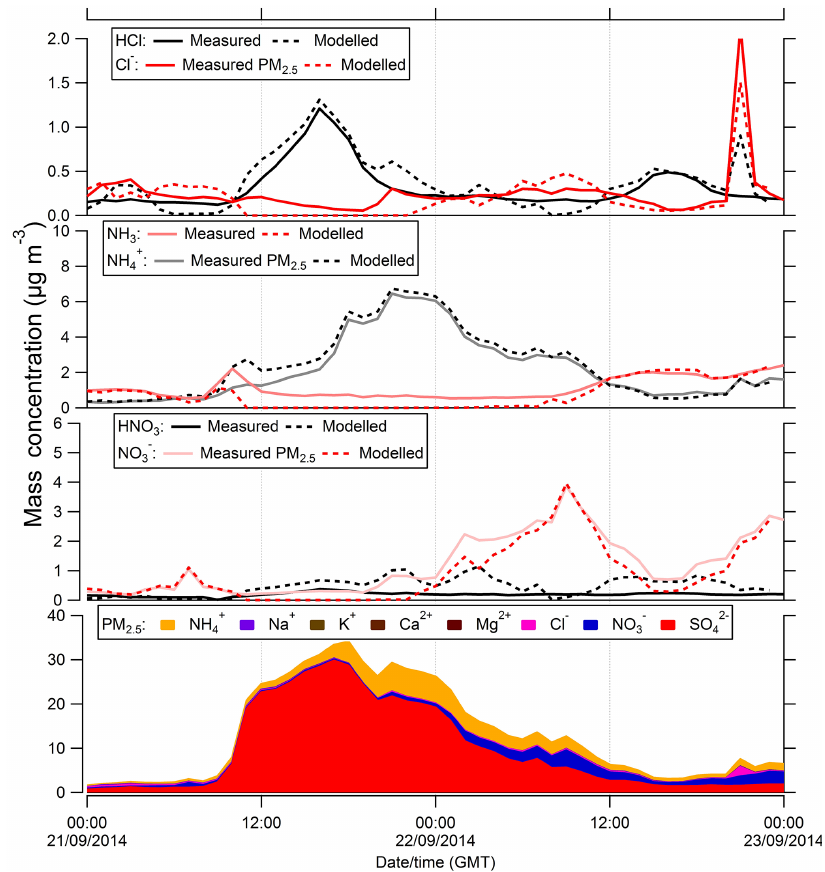
Figure 6. Top three panels: thermodynamic partitioning of gas and aerosol modelled by ISORROPIA-II compared with the measured con- centrations at Auchencorth Moss. The bottom panel shows a stacked representation of the chemical composition of PM 2 . 5 at Auchencorth Moss as resolved by the MARGA